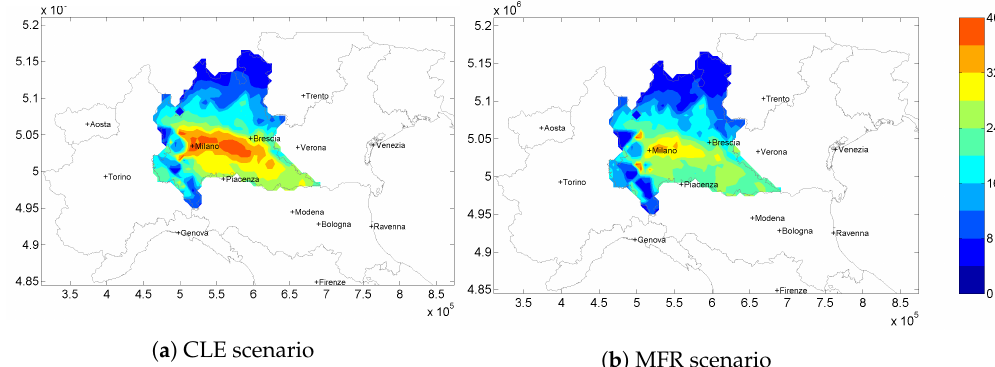
Figure 4. Maps of the PM 10 yearly average concentrations in [ µ g/m 3 ] for the current legislation scenario ( a ) (optimization base-case) and the MFR scenario ( b ).